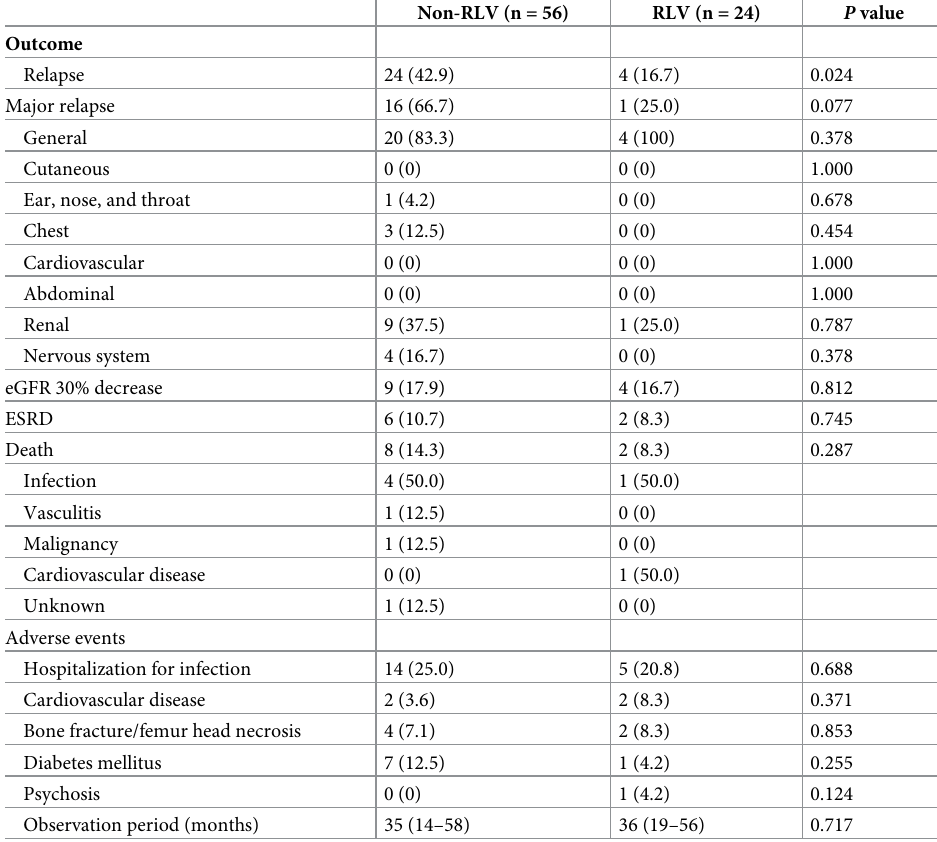
a Continuous data are presented as medians (interquartile range), and categorical data are expressed as